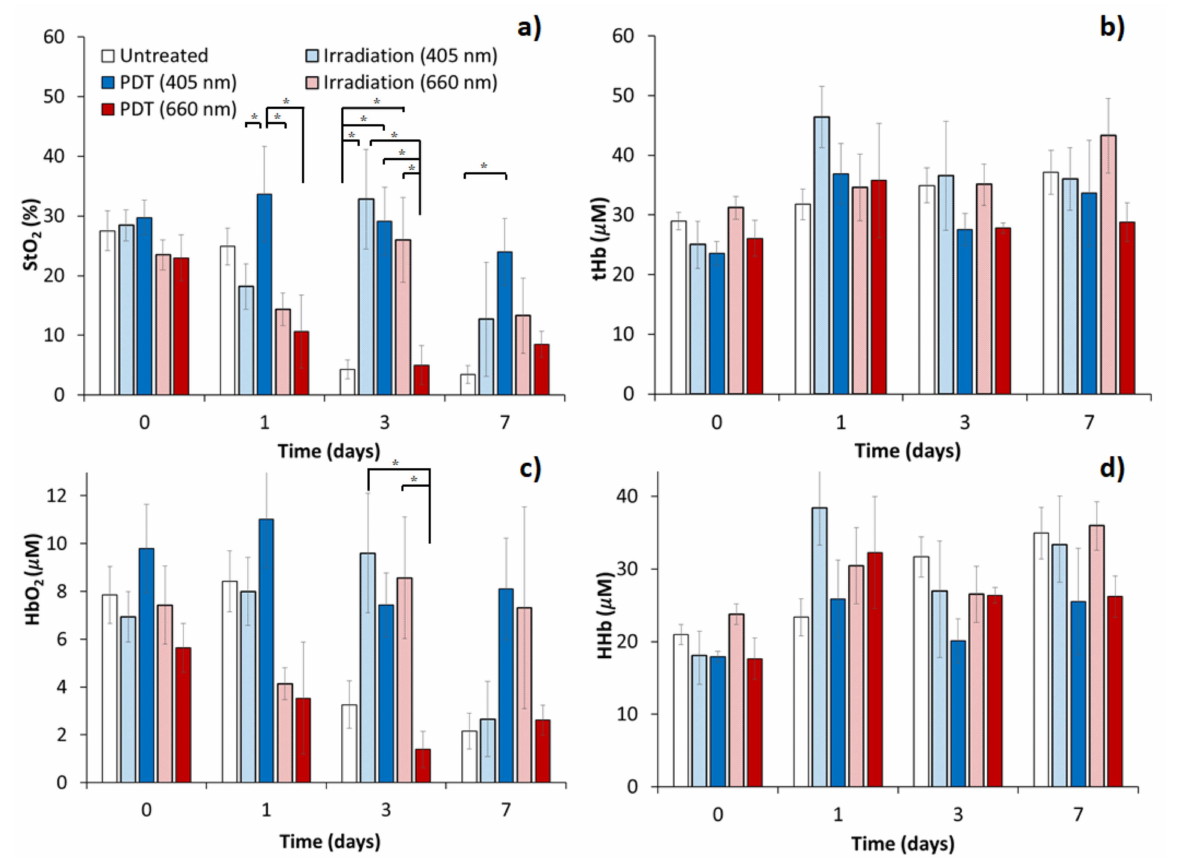
Figure 5. Blood oxygen saturation level ( a ), total hemoglobin ( b ), oxyhemoglobin ( c ) and deoxyhe- moglobin ( d ) content in CT26 tumor estimated by DOS after red- and blue-light PDT with Photolon and red- and blue-light irradiation only treatment. The data presented as M ± SEM, asterisk (*) shows statistically significant differences between the treatment groups ( p < 0.05, one-way ANOVA with Duncan